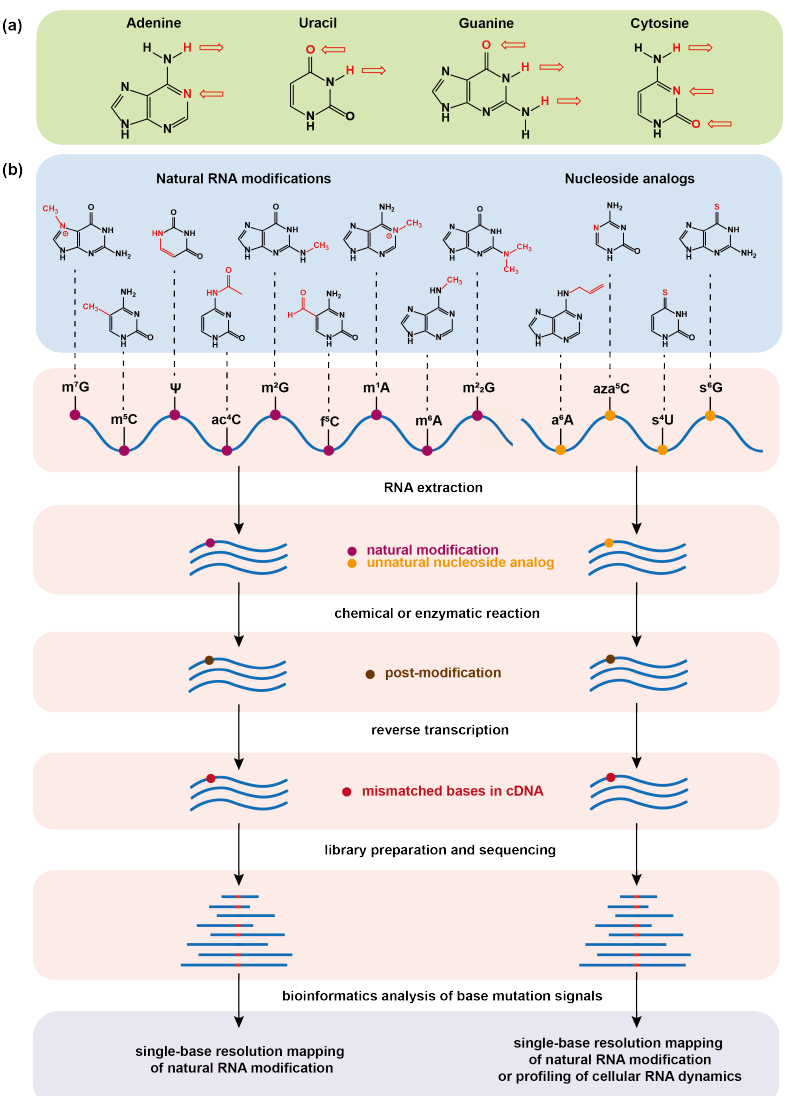
Figure 1. ( a ) Hydrogen bonding of the four basic bases that make up RNA in the Watson–Crick base-pairing principle. The arrow symbolizes the hydrogen bond and its direction points to the receptor of the hydrogen bond. ( b ) Schematic illustrations of chemical sequencing methods for determining natural RNA modifications at single base resolution or profiling cellular RNA dynamics by metabolic labeling. The chemical or enzymatic reactions convert natural RNA modifications or metabolically incorporated nucleoside analogs into new structural variants (post-modifications), which can induce base mismatch during reverse transcription of RNA into complementary DNA (cDNA) and can eventually be read by base mutation signals in the sequencing